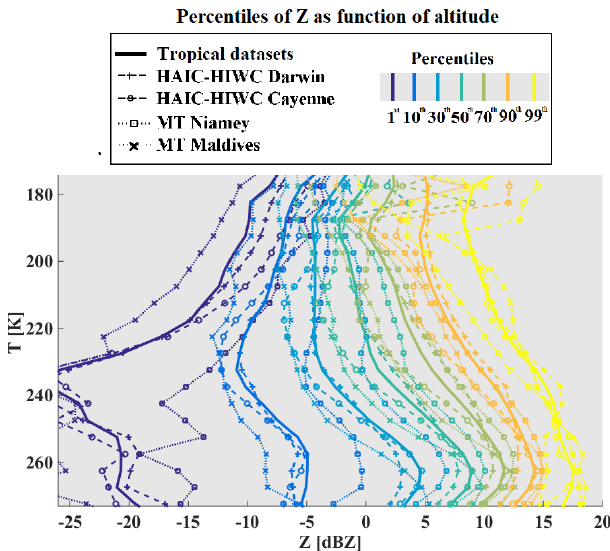
Figure 1. Percentiles of radar reflectivity factors in dBZ on x axis, as a function of temperature on y